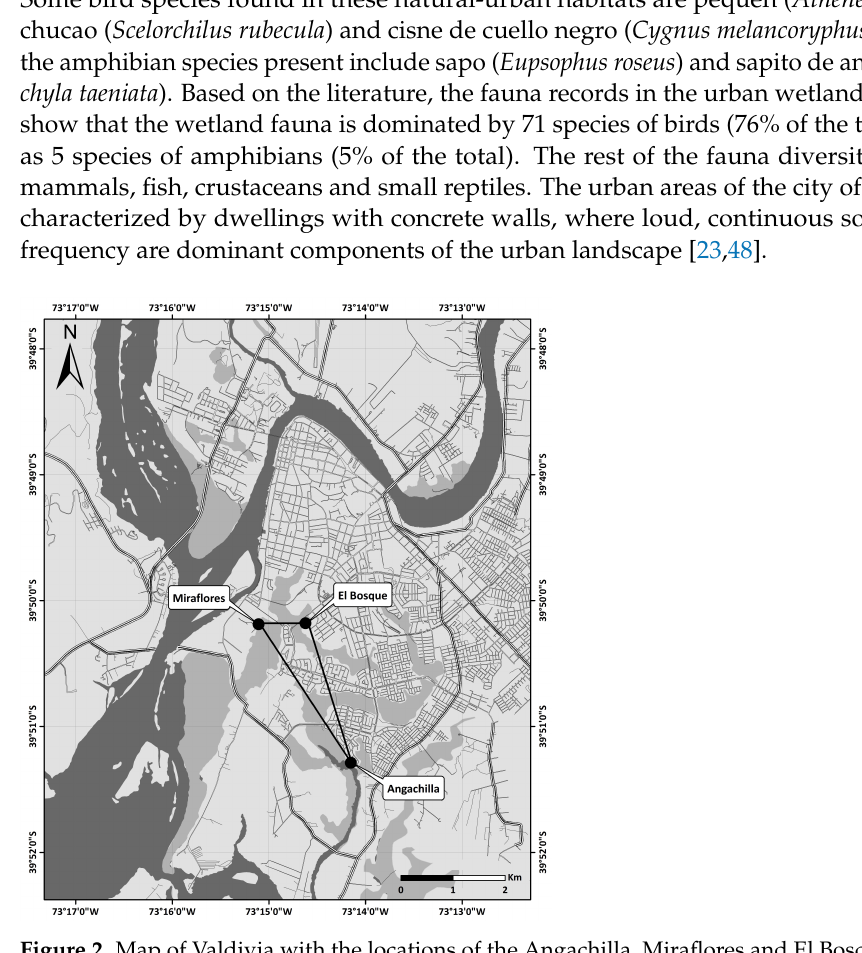
Figure 2. Map of Valdivia with the locations of the Angachilla, Miraflores and El Bosque wetlands.